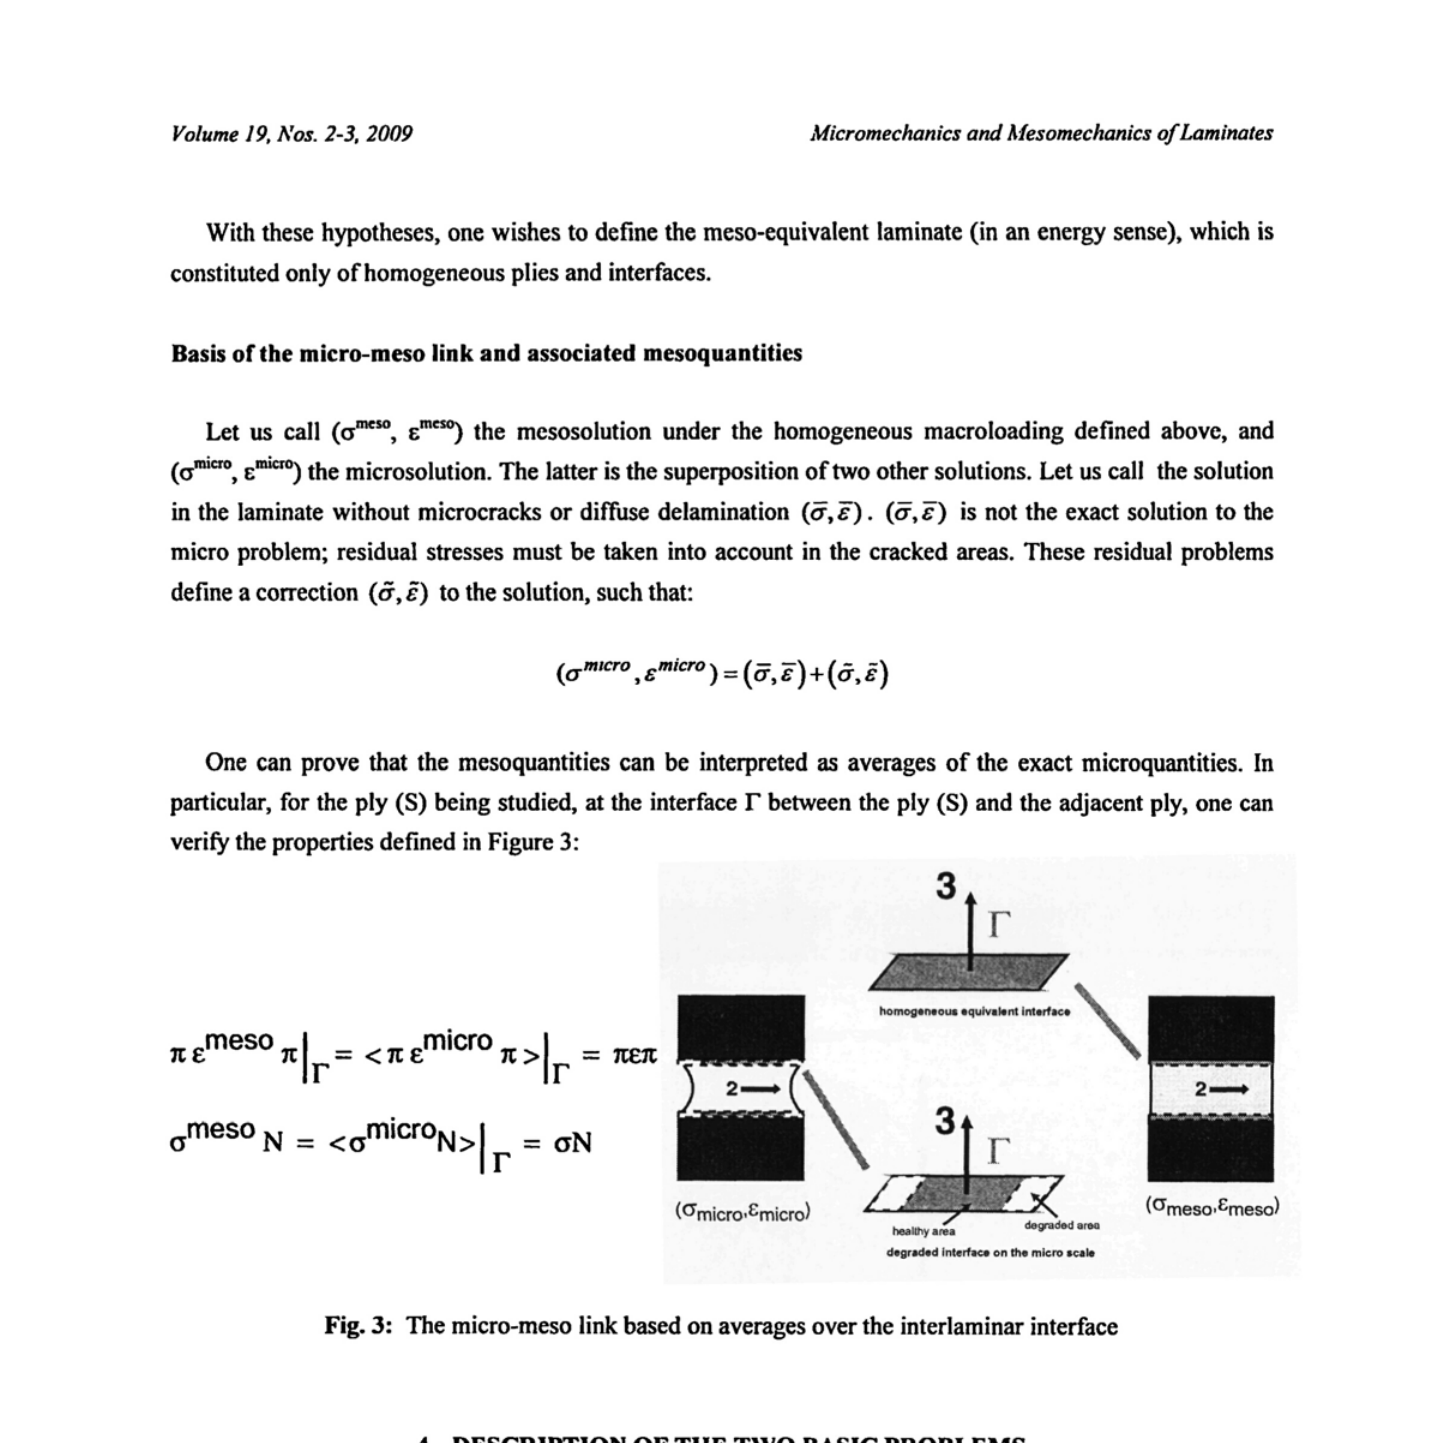
Fig. 3: The micro-meso link based on averages over the interlaminar